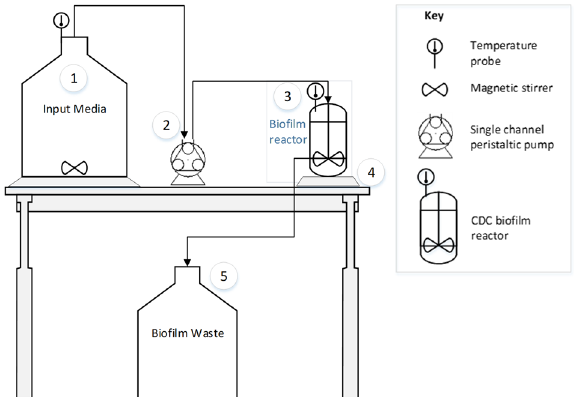
Fig. 5 Experimental set up of a Centre for Disease Control Bio fi lm Reactor. Standard experimental set-up of CDC bio fi lm reactor. Sterile input media (i.e. tryptone soya broth) is held within a 20 L Nalgene ™ carboy [1], and drawn through a single channel peristaltic pump [2] towards the CDC bio fi lm reactor [3]. A heating stir plate [4] maintained constant temperature and shear force within the